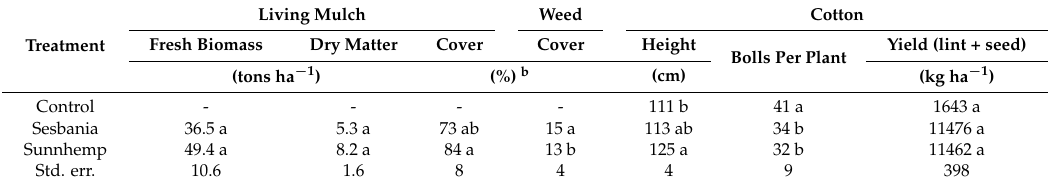
a Abbreviations: SS grass, sorghum sudan grass. b Values within each column not followed by a same letter(s) are significantly different according to Tukey’s test ( α = 0.05). c Visual estimations of living mulch and weed cover were made in absolute terms and as such, living mulch and weed cover may not add to 100%. Table 5. Least squares means of cotton, living mulch and weed parameters from sesbania and sunnhemp data pooled across Sites 1, 2, 3 and 4 during Year 2 a